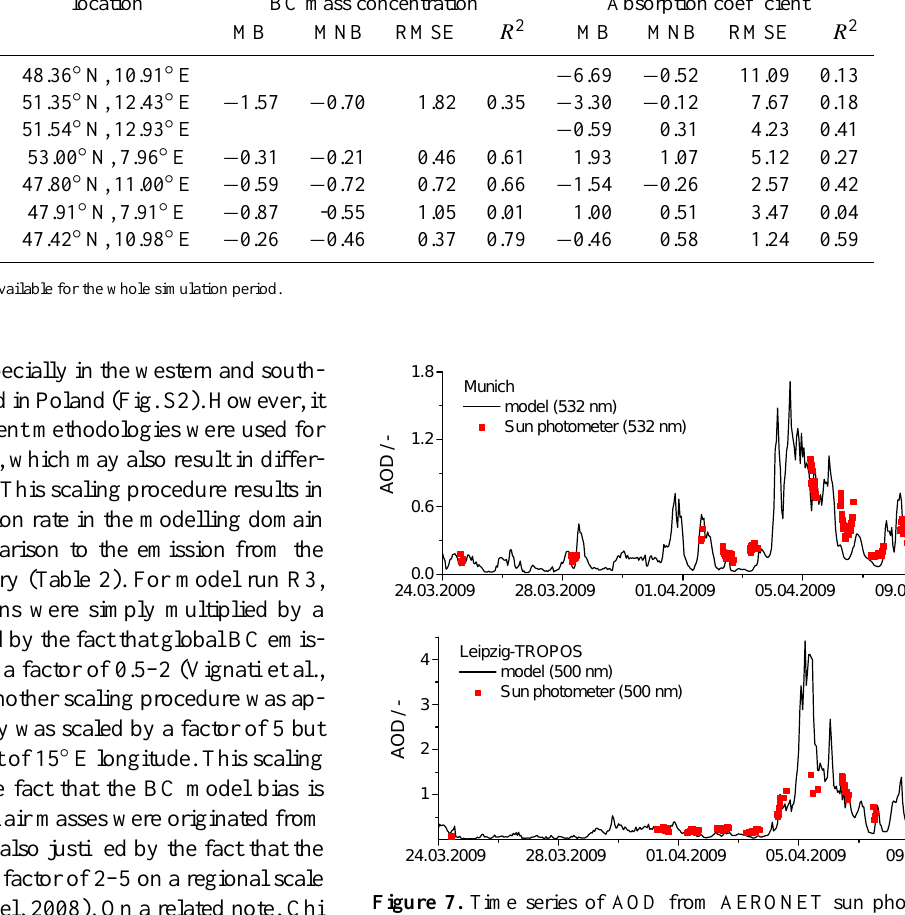
Table 4. Site-dependent statistical evaluation of model simulation of BC mass concentration and absorption coefficient in terms of mean bias (MB), mean normalized bias (MNB), root mean square error (RMSE) and coefficient of determination ( R 2 ). Site location BC mass concentration